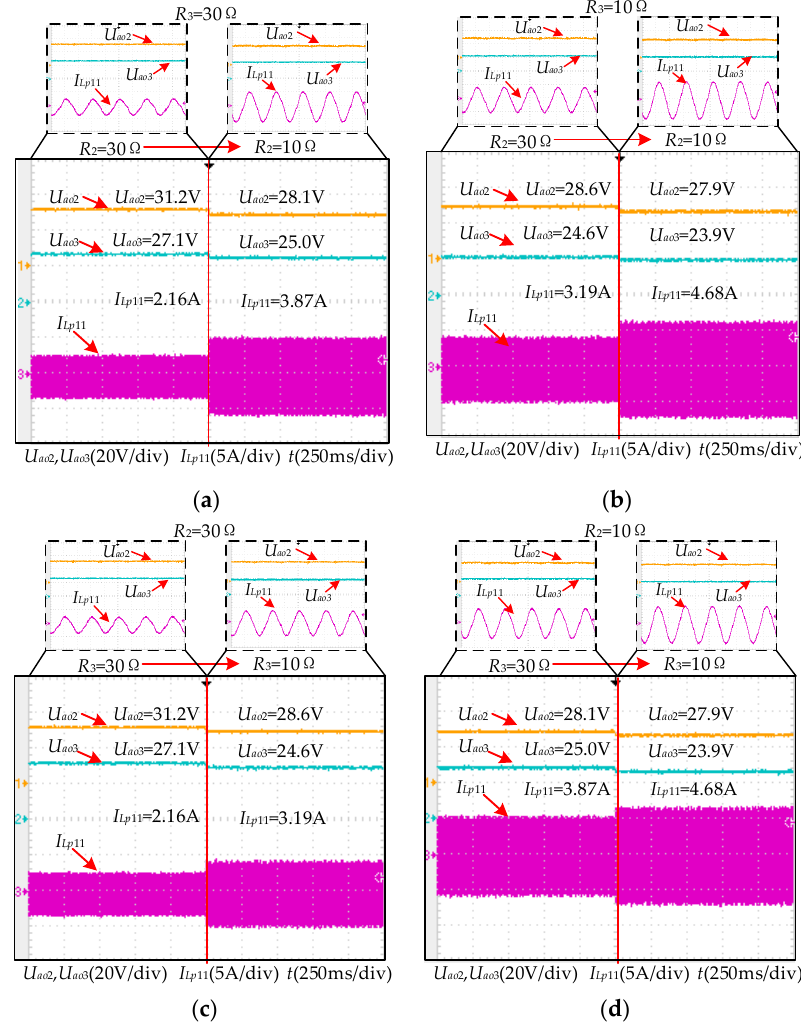
Figure 13. The variation of output voltages and input current with the loads. ( a ) R 3 = 30 Ω , and R 2 varies from 30 to 10 Ω ; ( b ) R 3 = 10 Ω , and R 2 varies from 30 to 10 Ω ; ( c ) R 2 = 30 Ω , and R 3 varies from 30 to 10 Ω ; ( d ) R 2 = 10 Ω , and R 3 varies from 30 to 10 Ω .